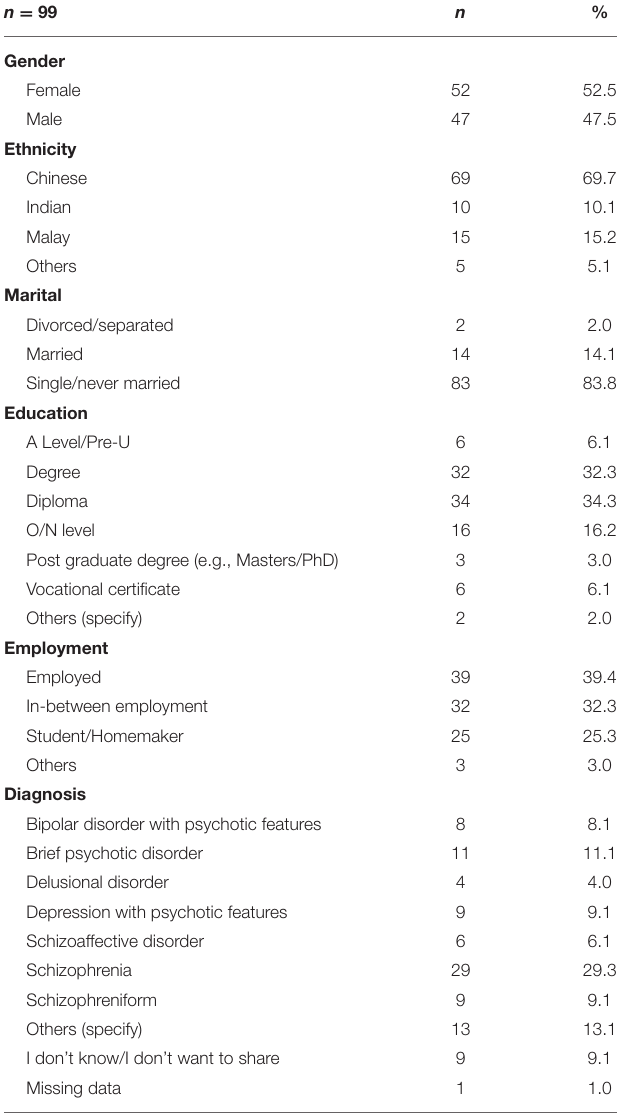
TABLE 1 | Sociodemographic profile of the participants. data at T1 and T2. Out of the five domains in the PTGI